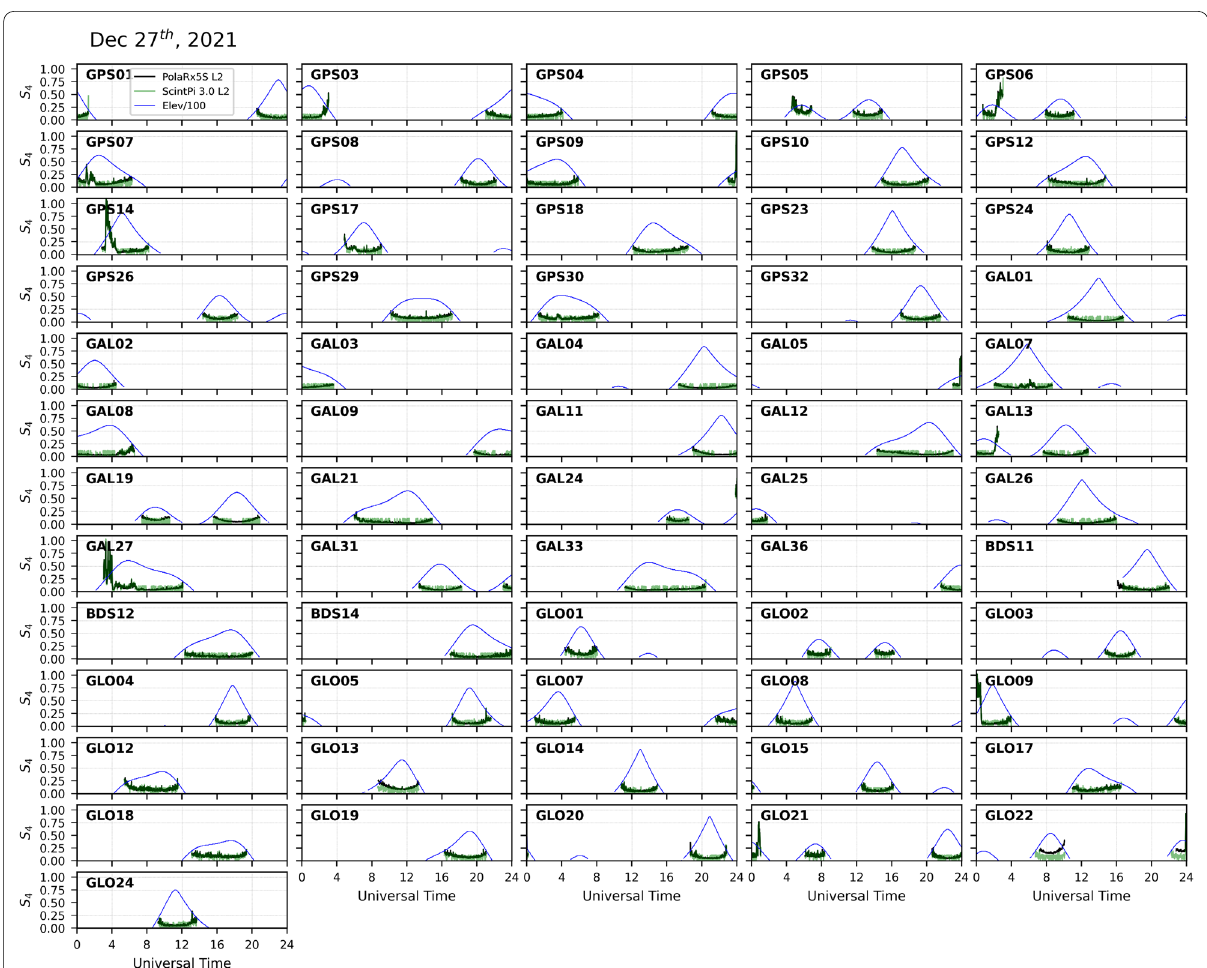
Fig. 4 Summary of L2 (~ 1.2 GHz) S 4 measurements made ScintPi 3.0 (green curves) and Septentrio PolaRx5S (black curves) on December 27, 2021. These monitors were collocated in Presidente Prudente (PPR), Brazil. The blue curves represent satellite elevation. The constellation and satellite identifier number are indicated in each